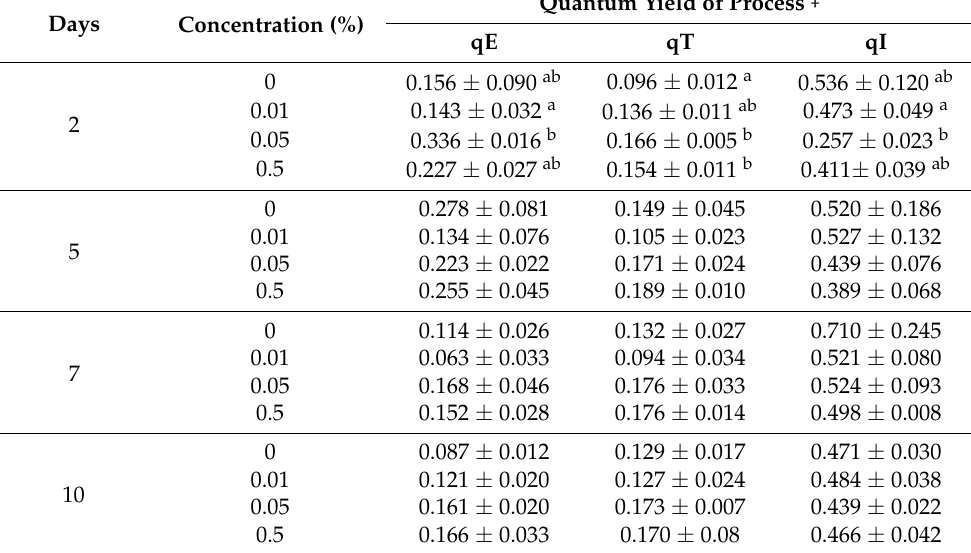
Table 1: Quantum yield of the photoprotective pathways of apple cultivar “Golden De- licious” on the background of Brevis ® inhibitor gradient and over time. Each value is an average of three biological repeats performed in duplicates, and the error values are standard error of the mean. Letter notations describe statistically significant difference ( p <